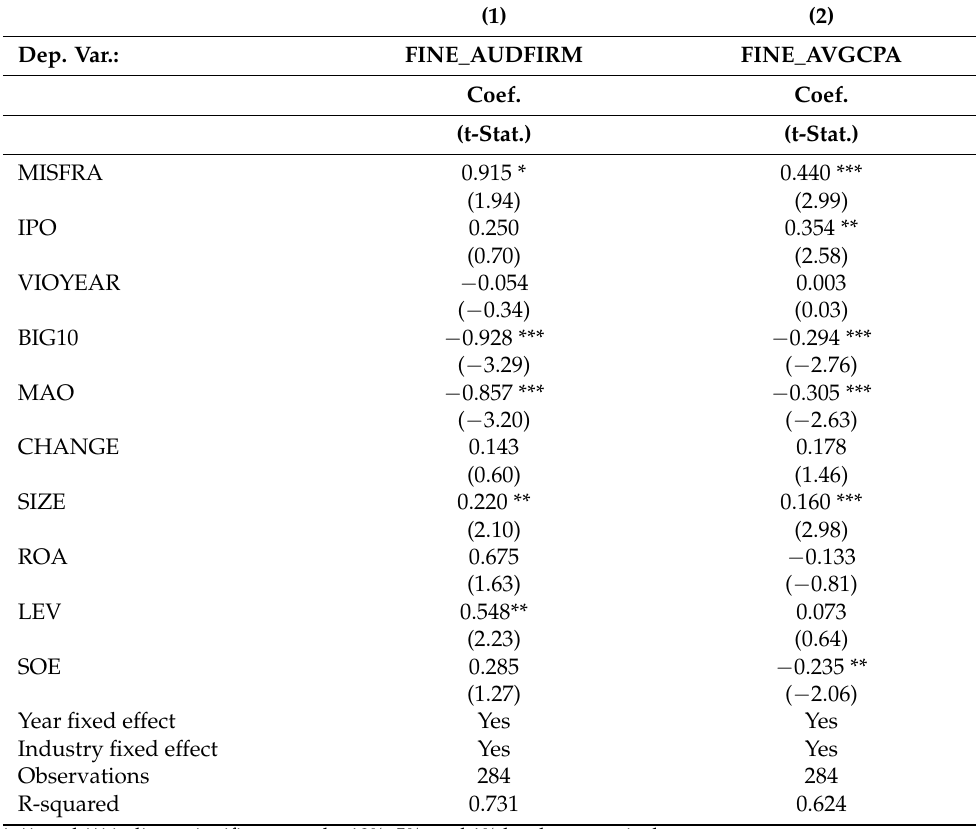
Table 6. Regression results of the